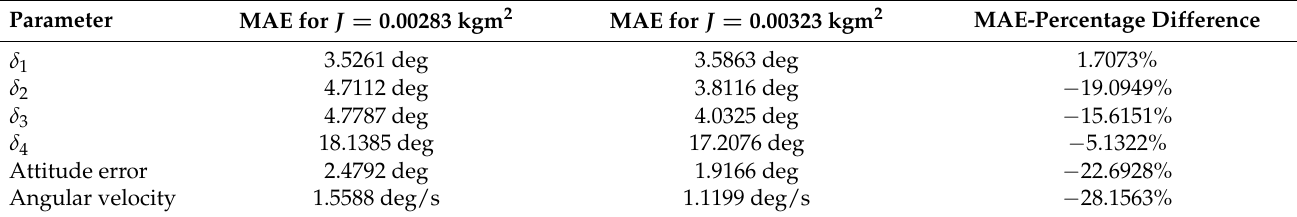
Table 9. MAE values for two different moments of